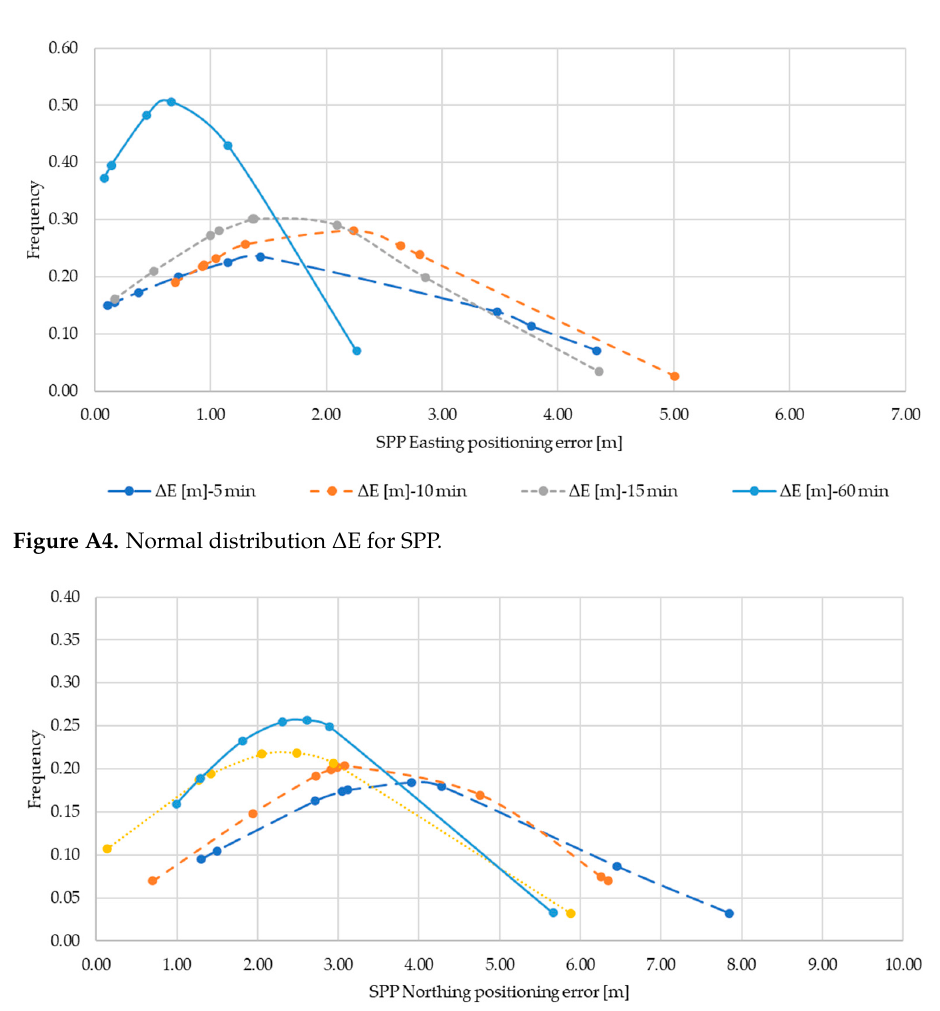
Figure A3. Normal distribution Δ U for DGNSS.